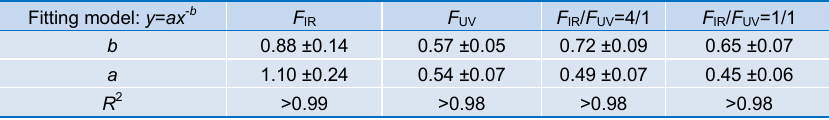
Fig. 6 | ( a ) Mean PA signal recorded from 26 spots irradiated with F UV = F IR = 0.5 J/cm 2 along with ( b ) Characteristic optical images corresponding to 10 incident laser pulses of IR (red margin) and UV (blue margin) radiation. Table 1 | Empirical fitting of PA data for different fluence